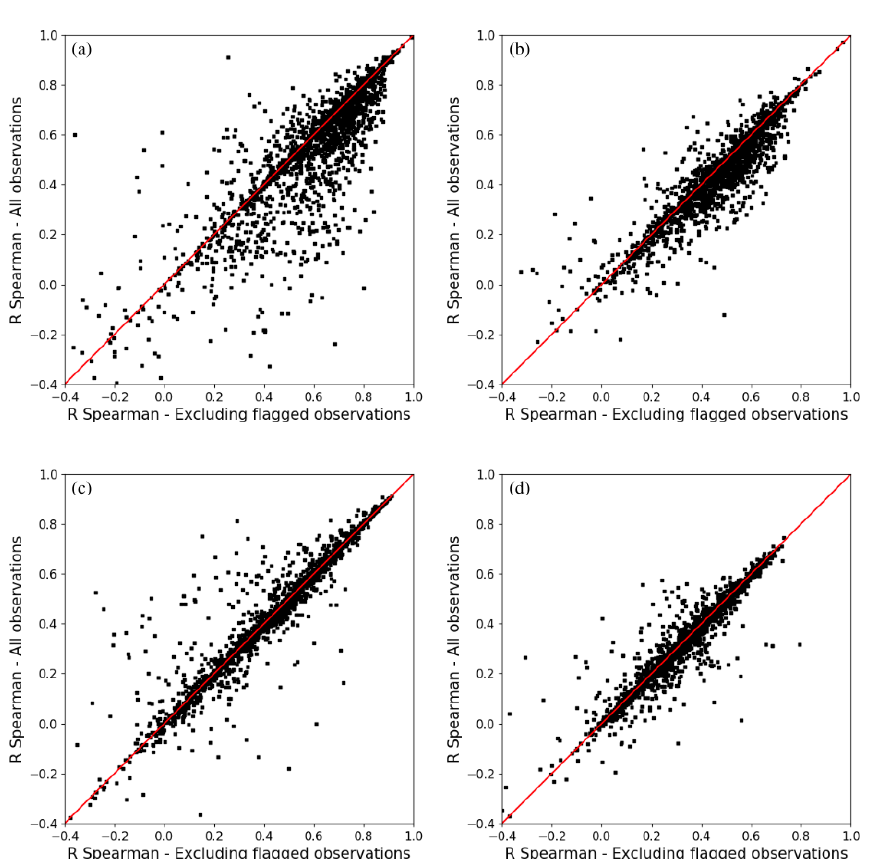
Figure F1. Scatterplots of R Spearman between ISMN and ERA5 and ISMN and ESA CCI v05.2 combined for absolute values and anoma- lies. A 35d moving average window was used to calculate anomalies. Each dot represents a single time series. (a) ERA5 absolute values. (b) ERA5 anomalies. (c) ESA CCI absolute values. (d) ESA CCI